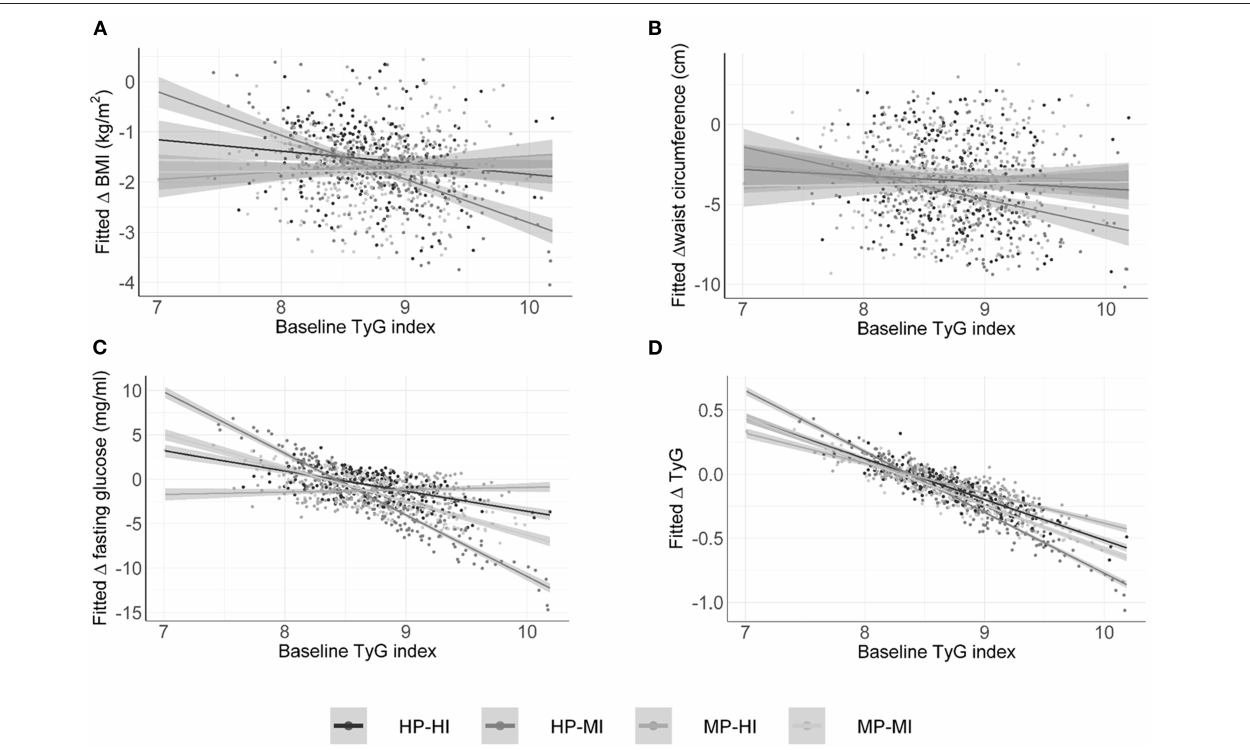
FIGURE 1 | Baseline triglyceride glucose index (TyG) prediction value for changes in anthropometric and metabolic outcomes categorized by the intervention groups of the PREVIEW study. HP, high protein; MP, moderate protein; HI, high intensity; MI, moderate intensity. (A) Fitted change in BMI; (B) Fitted change in waist circumference; (C) Fitted change in fasting glucose; (D) Fitted change in